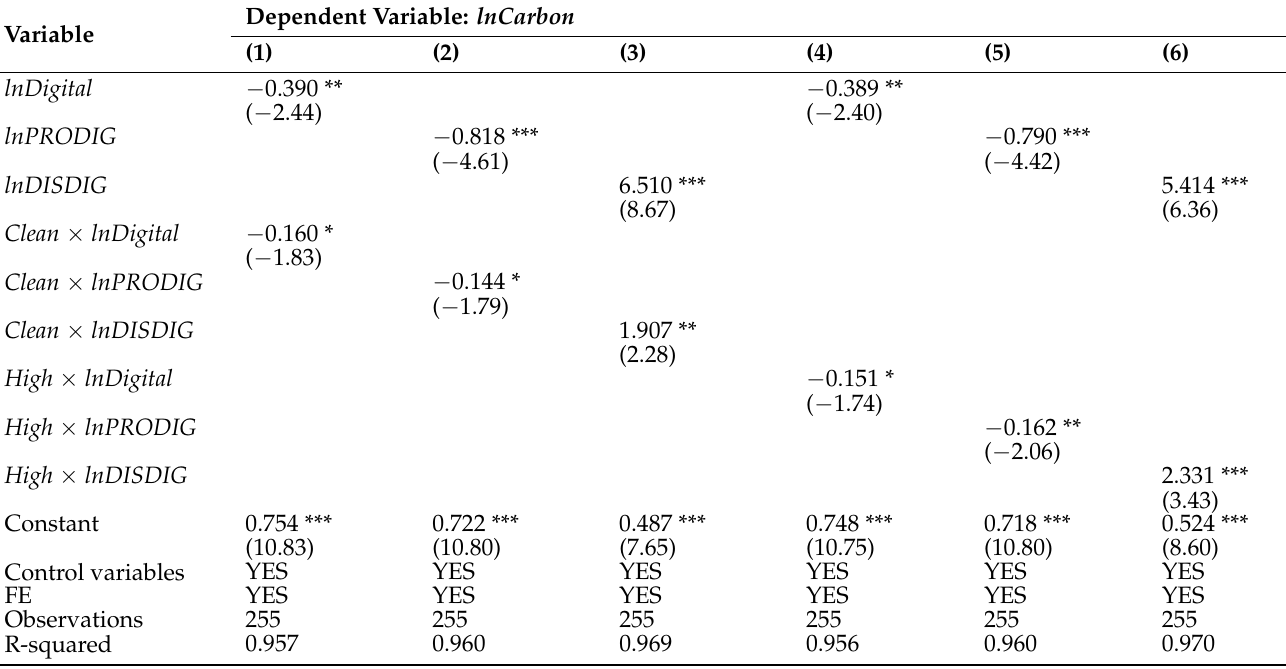
Table 9. Heterogeneity analysis